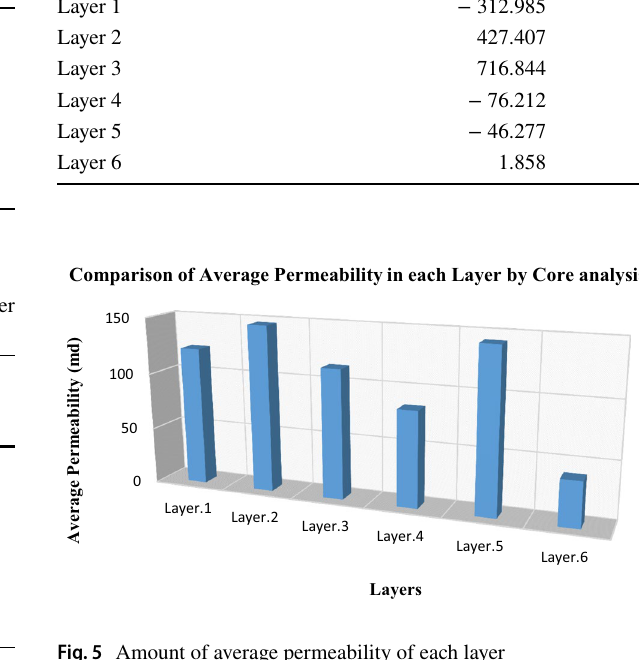
Fig. 5 Amount of average permeability of each